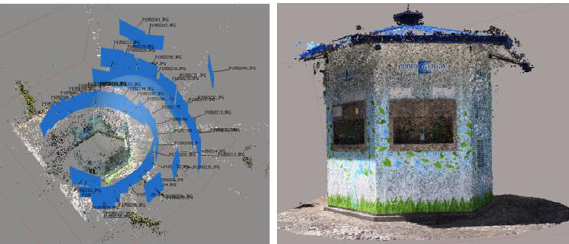
Figure 5. 3D model formation with images captured by